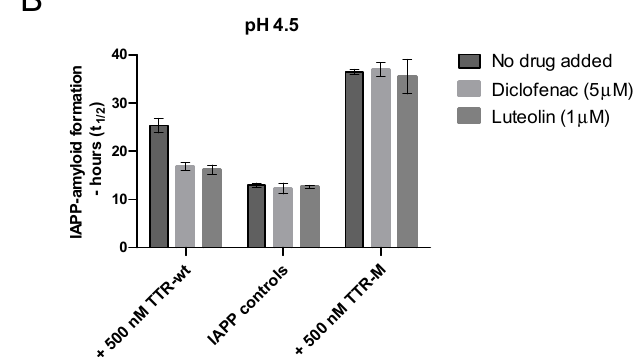
Figure 5. Inhibition of IAPP amyloid formation by TTR as a function of TTR-stabilizing ligands at neutral and low pH. Amyloid formation of IAPP incubated in PBS (pH 7.5) or 25 mM citric acid pH 4.5, 150 mM NaCl, was probed against 500 nM of TTR-wt as well as TTR-M in the presence versus absence of the tetramer stabilizing drugs luteolin (1 µ M) and diclofenac (5 µ M). Figure ( A ) illustrates the result at neutral pH at 5 µ M of IAPP. Figure ( B ) illustrates the results at pH 4.5 (note that 10 µ M of IAPP was used in the setup at low pH). A significant reduction of the inhibiting propensity of the TTR stabilizing drugs was observed regarding the tetrameric TTR-wt, p -value < 0.005 (unpaired t -test), both at neutral and low pH. TTR-M, which is unable to bind to the ligands, was unaffected at neutral and low pH.